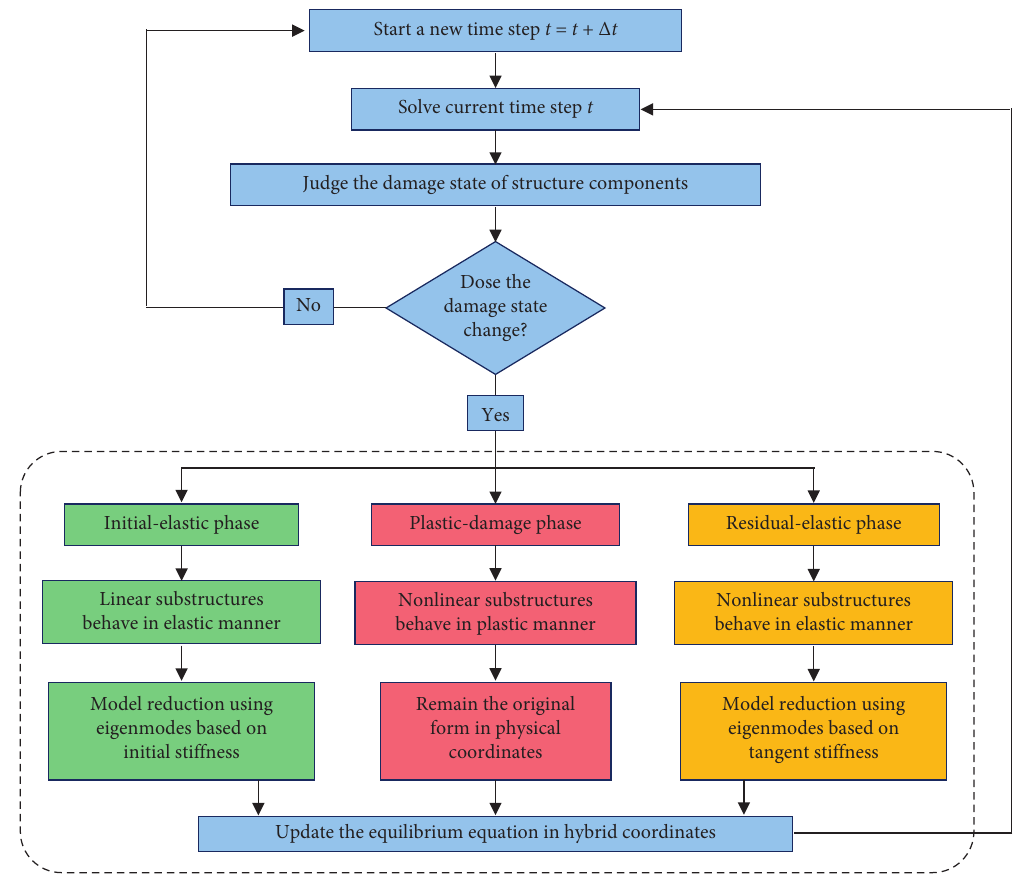
Figure 5: Flowchart of the AMCB-E